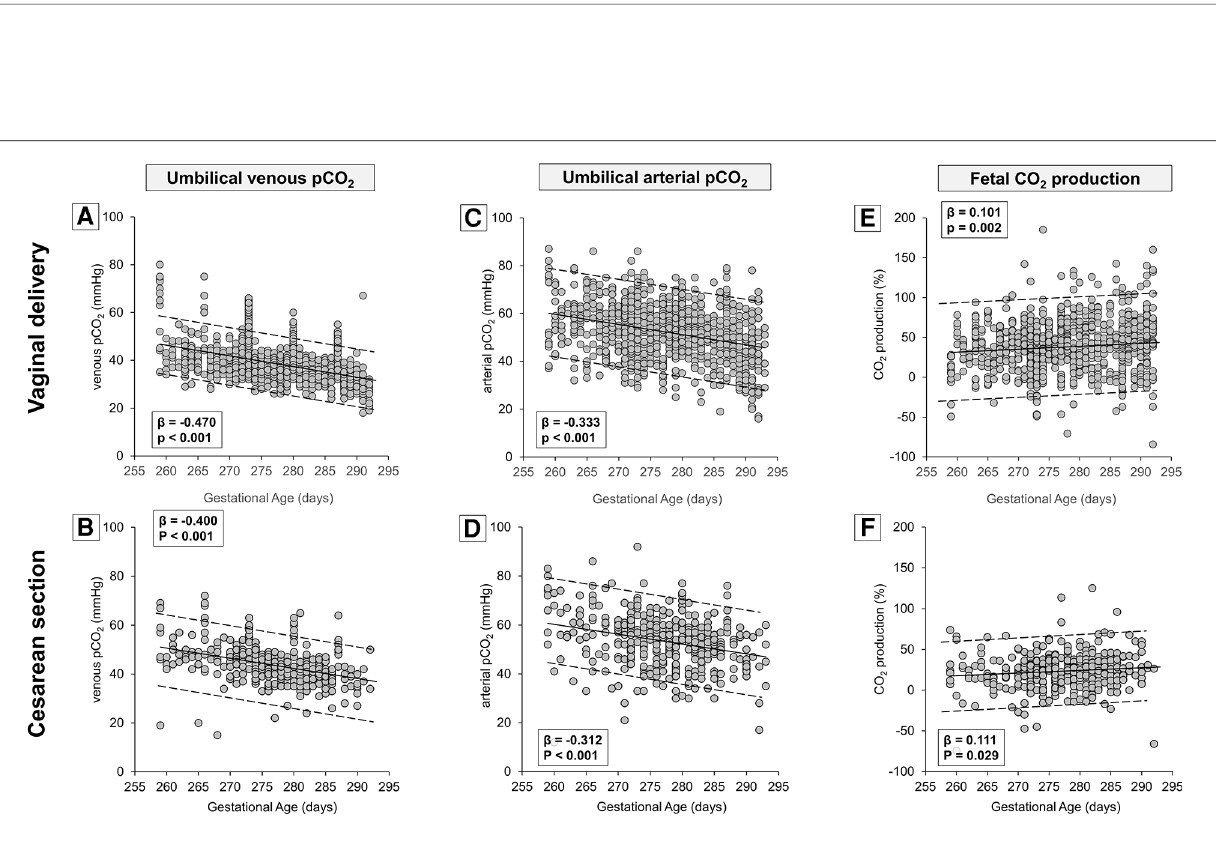
FIGURE 5 Scatter plots with regression lines and 95% prediction intervals representing umbilical-cord carbon dioxide levels [venous PaCO 2 , panel A ( n =934) — panel B ( n =388); arterial PaCO 2 , panel C ( n =943) — panel D ( n =396); fetal CO 2 production, panel E ( n =932) — panel F ( n =385)] strati fi ed by modality of